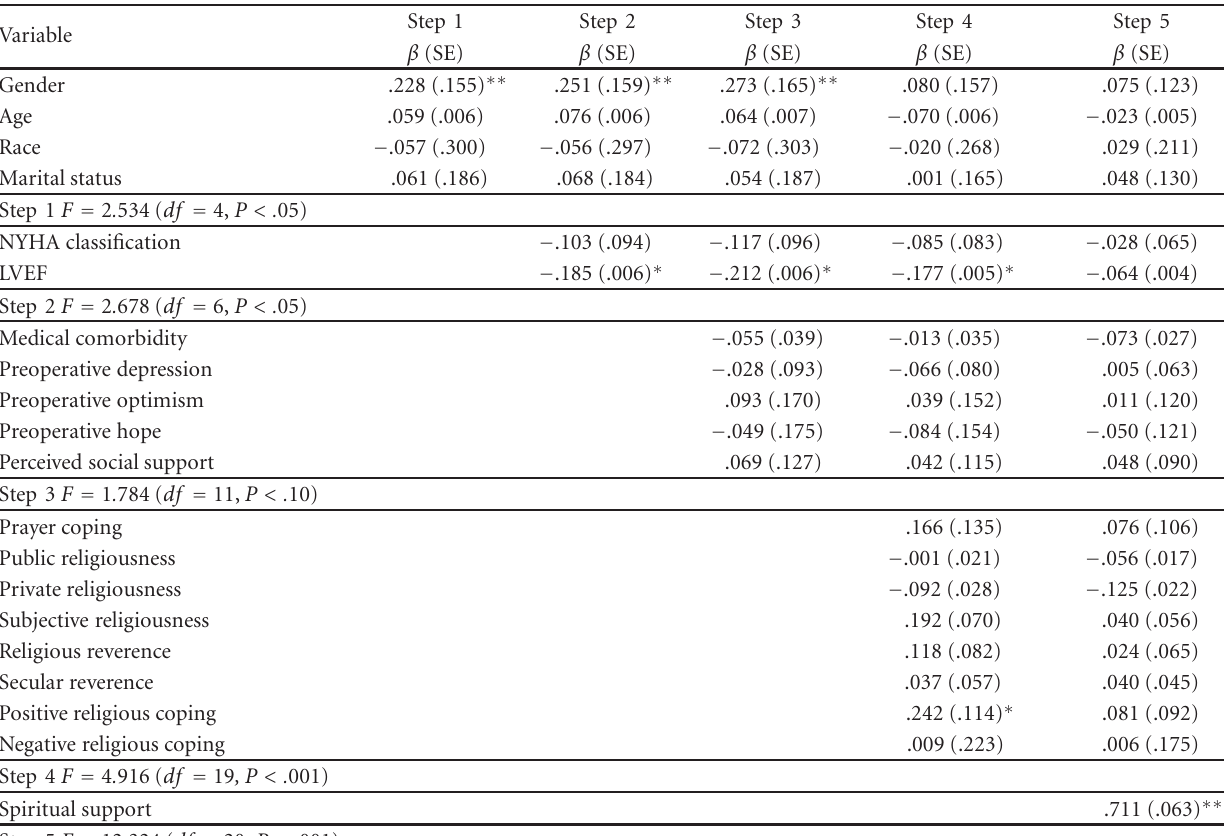
Table 1: Regression predicting